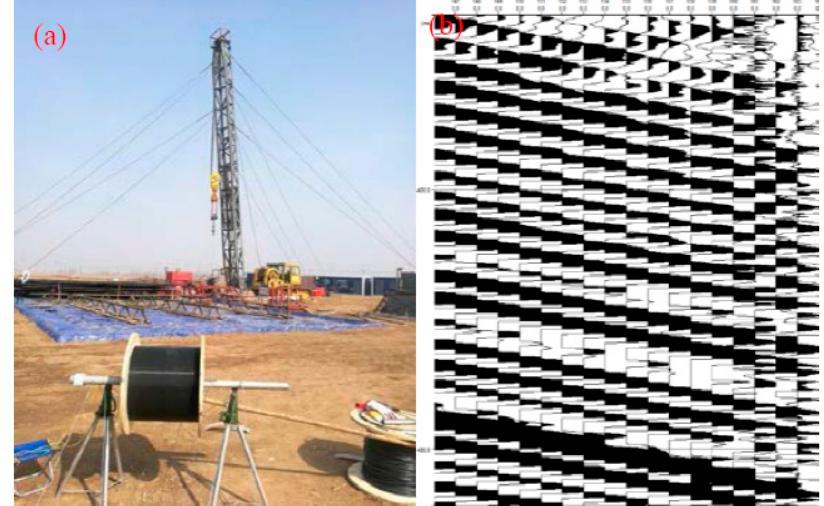
Figure 17. ( a ) The VSP test site. ( b ) The VSP test result [76].